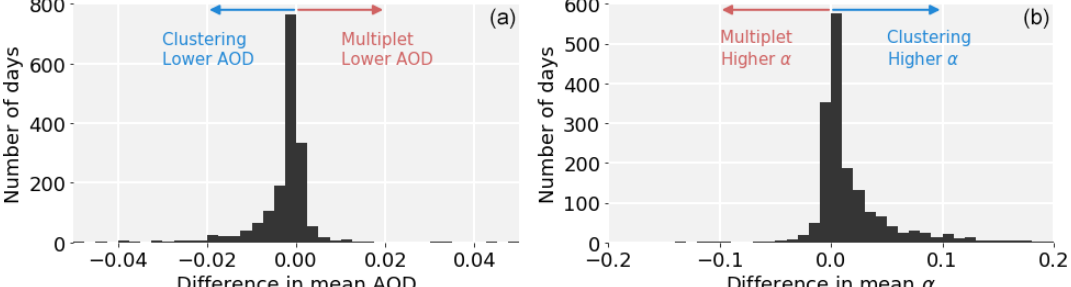
Figure 6. Histogram of the Clustering minus Multiplet difference in daily mean of AOD at 501nm (a) and of α (b) . Negative/positive values mean that the daily mean is lower/higher when screened by Clustering.